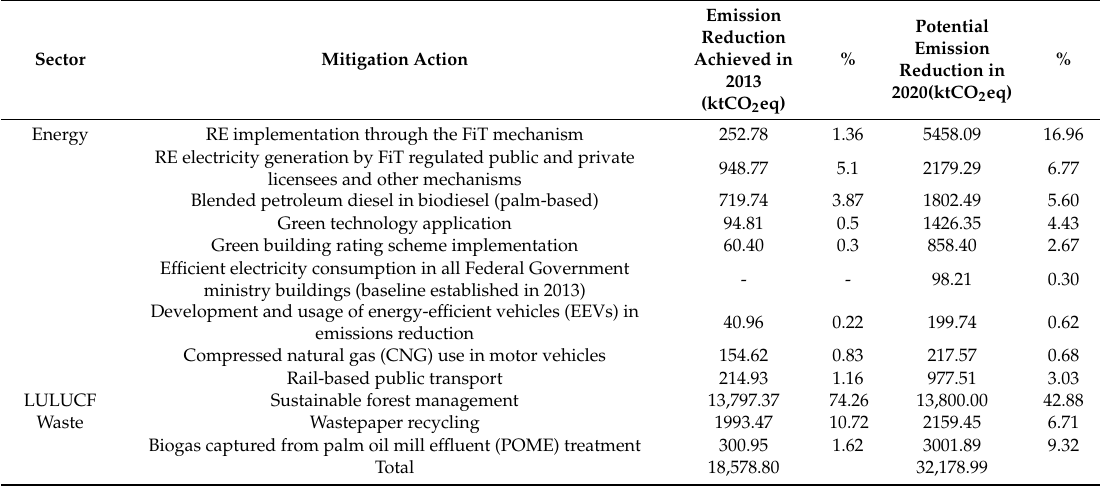
Table 2. List of achieved emissions reductions in 2013 and projected for 2020